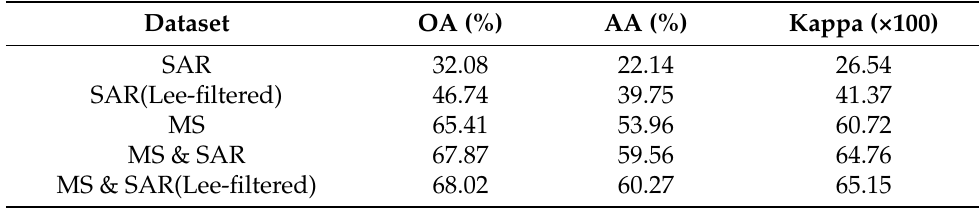
Table 5. Mean values of OA, AA, and kappa evaluated on the So2Sat LCZ42 dataset using different data sources, where SAR refers to using all of the eight bands and SAR (Lee-filtered) refers to using only the fifth and sixth bands as described in Table 1.